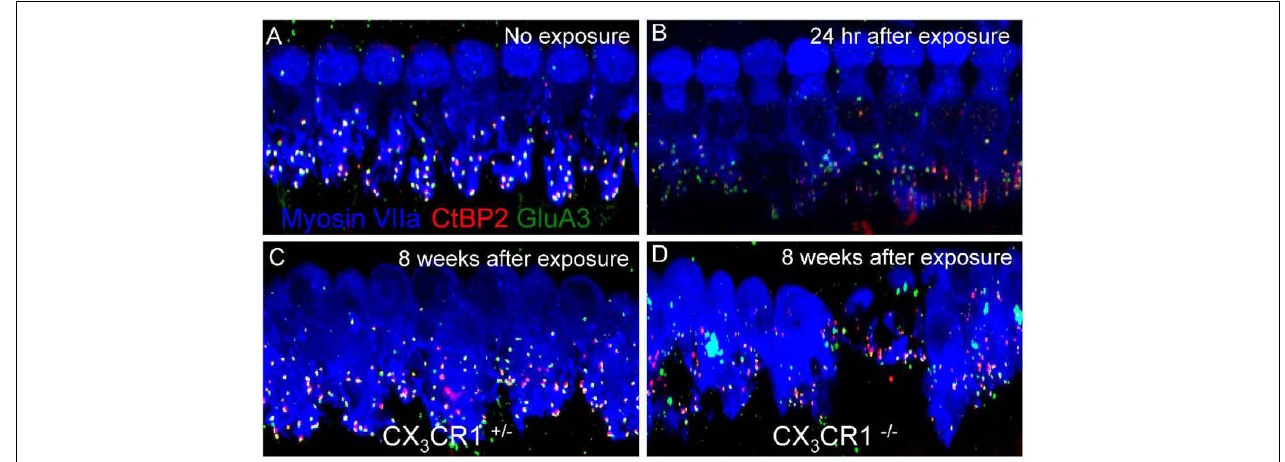
FIGURE 2 | Ribbon synapses in CX3CR1C + / – and CX3CR1 – / – mice after noise exposure. Representative micrographs are shown for the 32-kHz region.